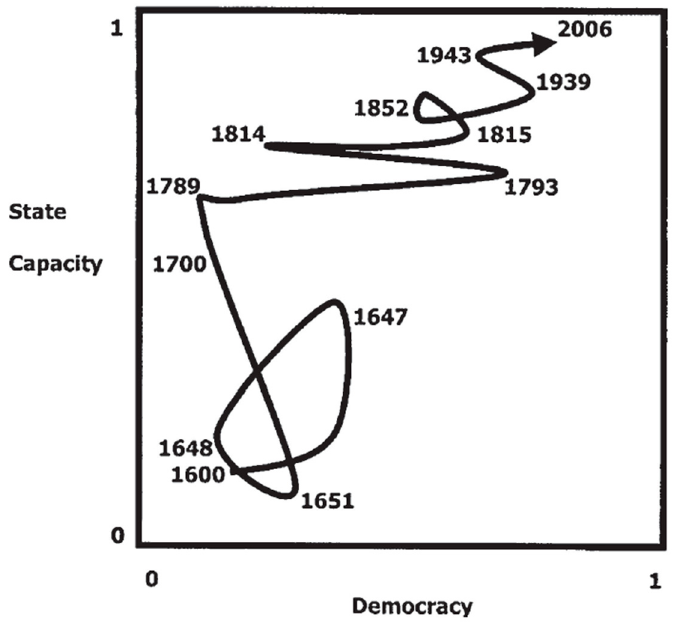
Figure 1. Schematic trajectory of French National Regimes, 1600–2006. Source Tilly in (Castañeda and Schneider 2017, p. 191).